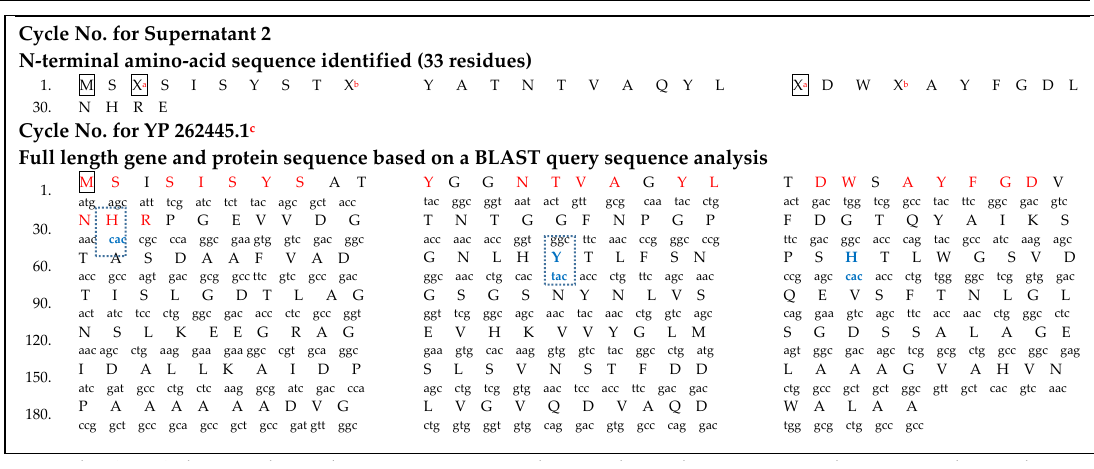
Table 2. Results of a BLAST query sequence analysis based on the N-terminal amino-acid sequence identified band from Supernatant 2.